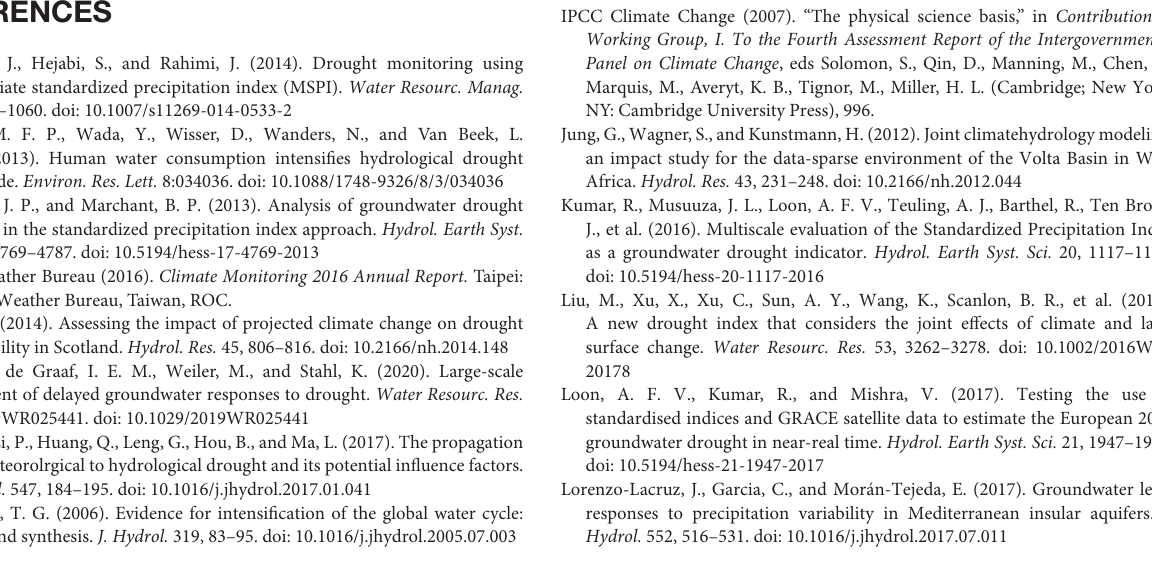
Mean Mean drought drought drought events duration